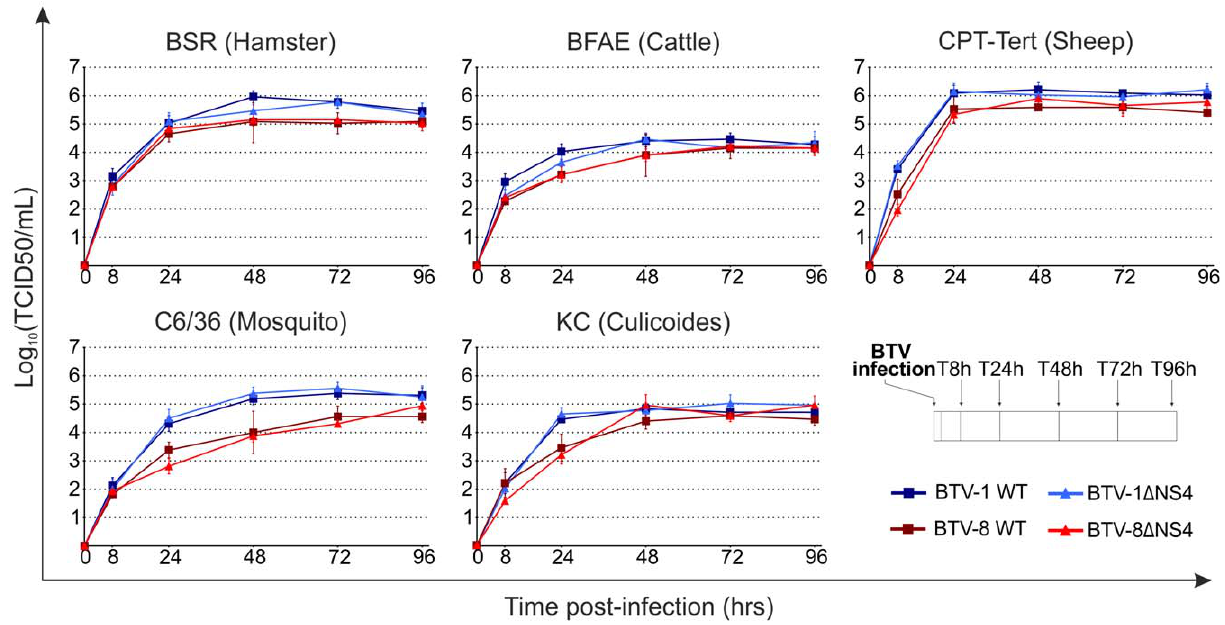
Figure 5. Invitro growth properties of rescued WT and D NS4 viruses. Growth curves of BTV-8 (dark red, square), BTV8- D NS4 (red, triangle), BTV-1 (blue, square) and BTV1- D NS4 (light blue, triangle) in cell lines derived from different species. BSR (hamster), BFAE (cattle), CPT-Tert (sheep), C6/ 36 (mosquito) and KC ( Culicoides ) cells were infected at a MOI of 0.05 and supernatants collected at 8, 24, 48, 72 and 96 h after infection. Supernatants were then titrated on BSR cells by limiting dilution analysis and the virus titers expressed as log 10 (TCID 50 /ml). In parallel, each virus preparation was also re-titrated by limiting dilution analysis to control that equal amounts of input virus was used in each experiment. Experiments were performed independently twice, each time in duplicate, using two different virus stocks.